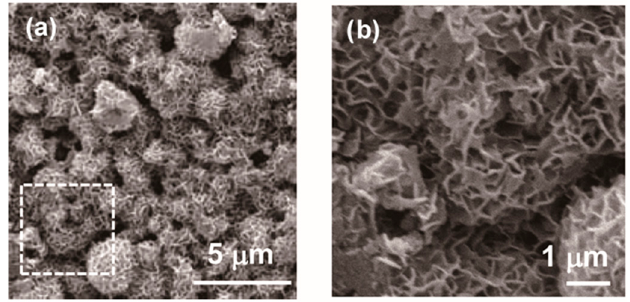
Figure 4. SEM micrographs of Ag-TCP(5) cement. SEM images of the surface of Ag-TCP(5) cement. ( b ) represents high magnification of indicated area. Bars indicate 5 μ m ( a ) and 1 μ m ( b ), respectively.